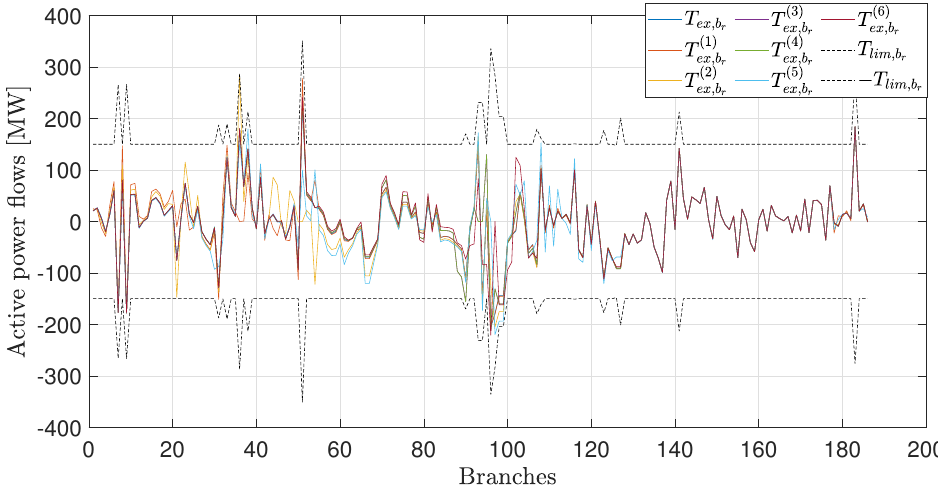
Figure 9. Active power flows after active power control − Scenario